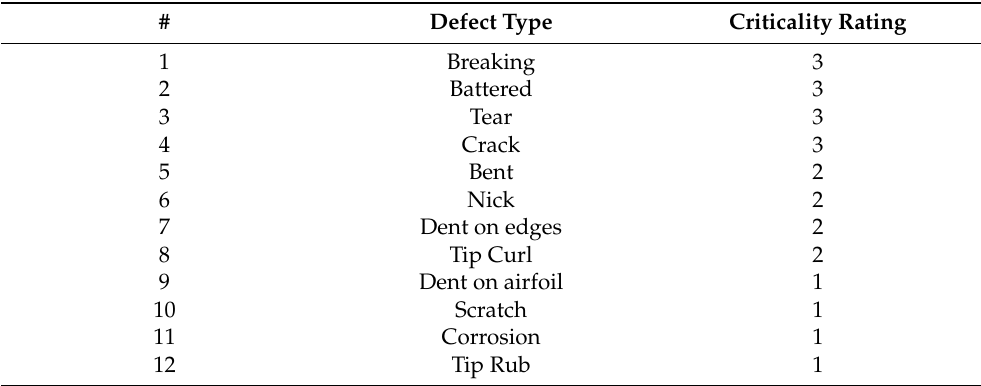
Table 6. Criticality rating for each defect